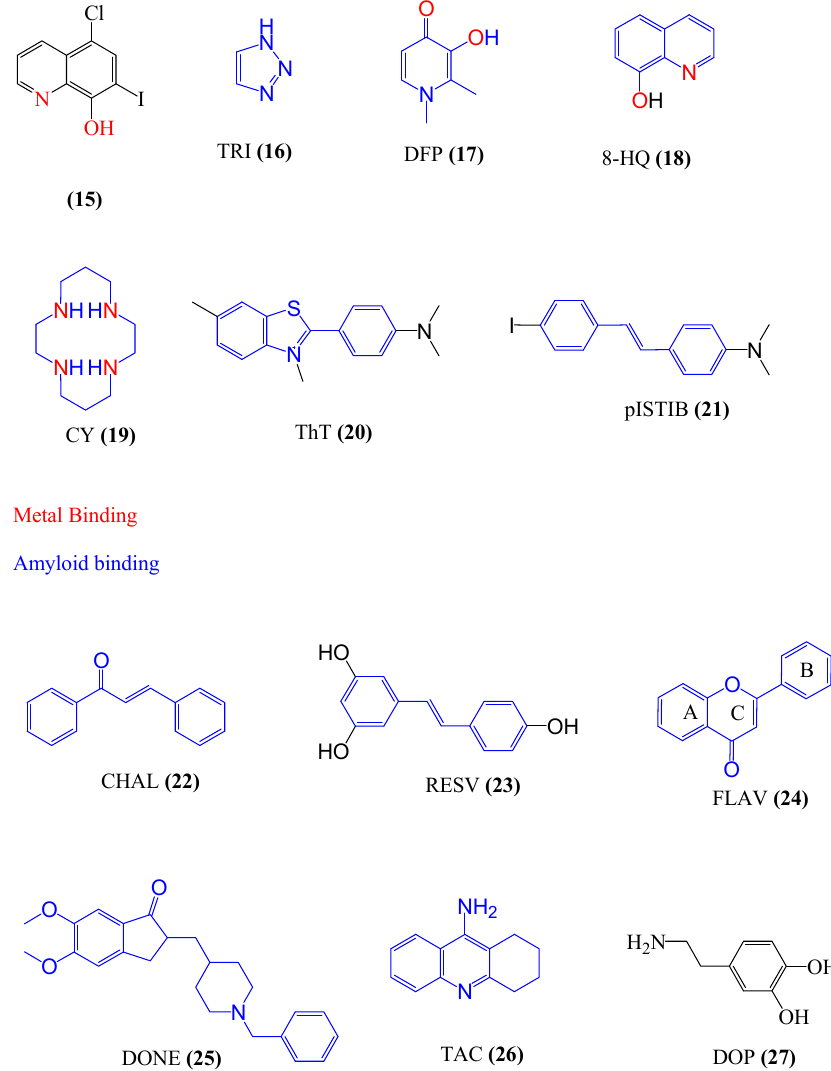
Figure 9. Template molecules for the development of multifunctional compounds. Clioquinol molecule, 5-chloro-7-iodo-quinolin-8-ol ( 15 ); triazole (TRI), 1,2,3,4-tetrahydroacridin-9-amine ( 16 ); diferiprone (DFP), 1,2-dimethyl-3-hydroxypyridin-4-on ( 17 ); 8-hydroxyquinoline (8-HQ) ( 18 ), cyclam (CY) ( 19 ), thioflavine T (ThT), 4-(3,6-dimethyl-1,3- benzothiazol-3-ium-2-yl)-N,N-dimethylaniline ( 20 ); p -I-stilbene (pISTIB) (E)-4-iodo-4 (cid:48) -dimethylamino-1,2-diphenylethylene ( 21 ); chalcone (CHAL), (2E)-1,3-diphenylprop-2-en-1-one ( 22 ), resveratrol (RESV), 3,5,4 (cid:48) -trihydroxy-trans-stilbene ( 23 ); flavone (FLAV), 2-phenyl-4H-1-benzopyr-4-one ( 24 ); donepezil (DONE), 2-[(1-benzylpiperidin-4-yl)methyl]- 5,6-dimethoxy-2,3-dihydro-1H-inden-1-one ( 25 ), tacrine (TAC), 1,2,3,4-tetrahydro-9-acridinamine ( 26 ) and dopamine (DOP), 4-(2-amino-ethyl)-benzene-1,2-diol ( 27